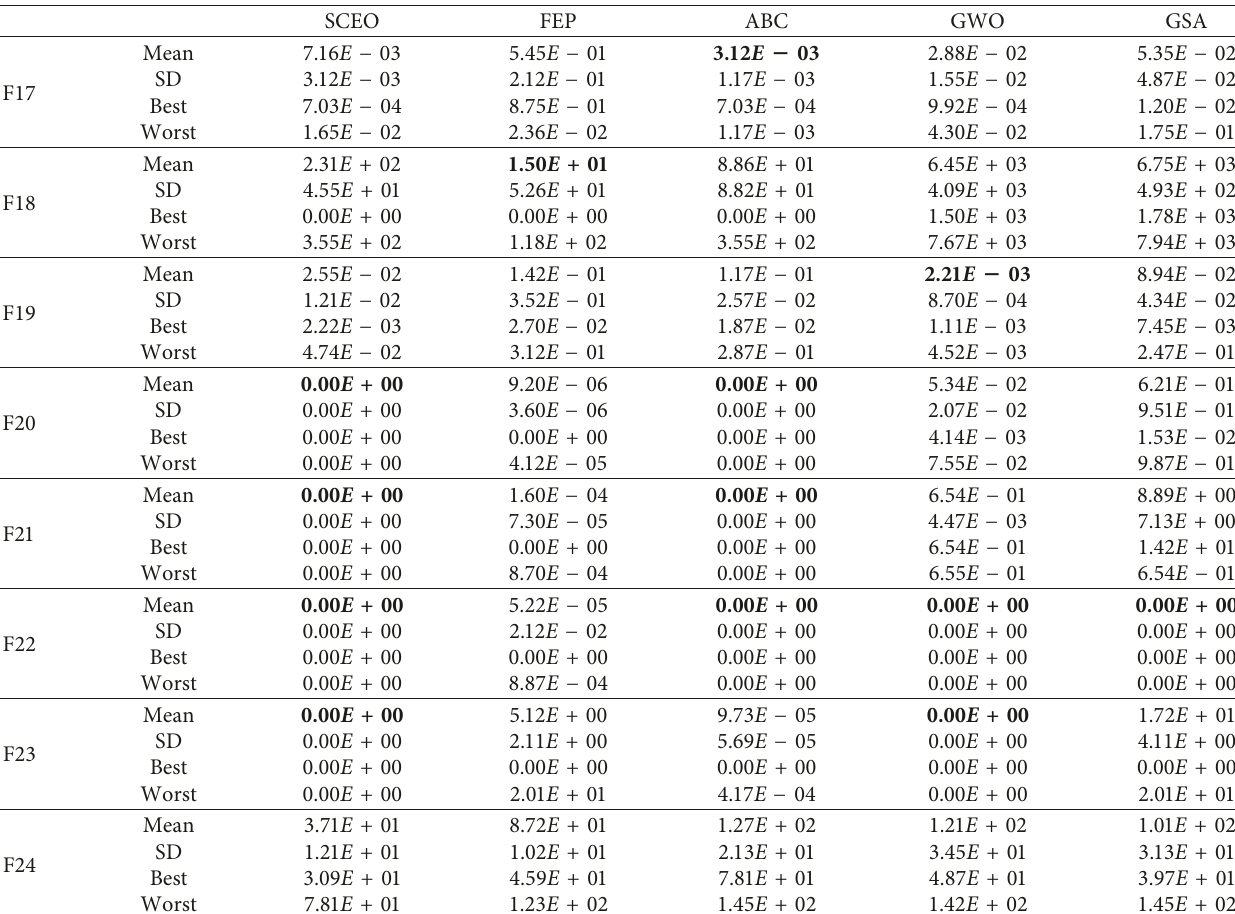
Table 8: Comparison with PSO [17], FEP [15], DE [14], ABC [29], GWO [7], and GSA [30].